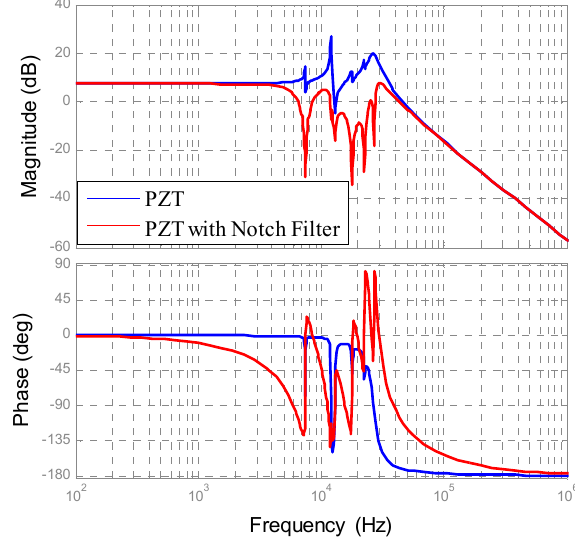
Figure 12. The frequency response of the complicated PZT model and complicated the PZT model with a notch filter .